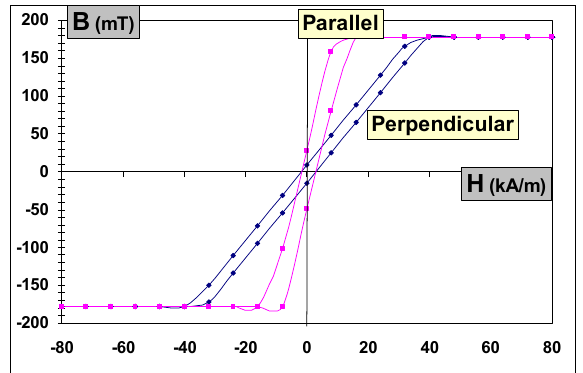
Figure 7: VSM hysteresis curves of a YIG substrate for parallel and perpendicular applied